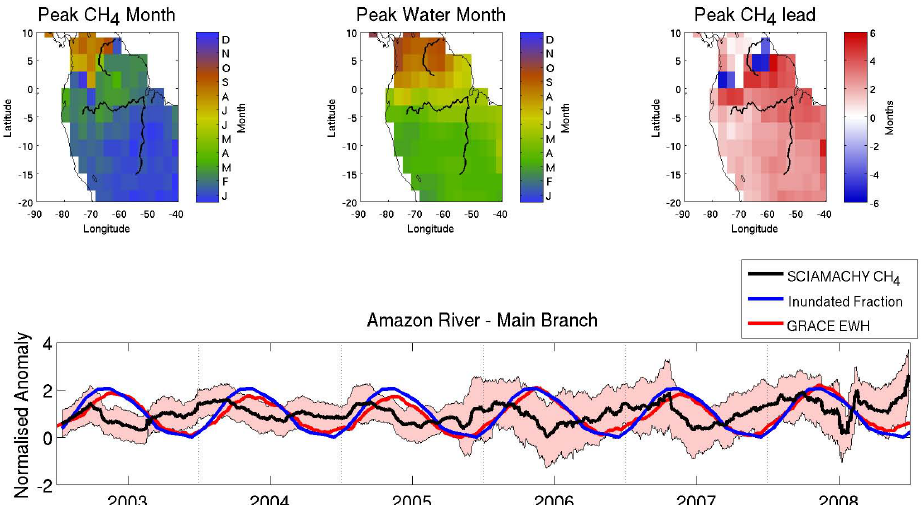
Fig. 1. Top: The timing (month of year) of peak CH 4 concentrations from SCIAMACHY (left), peak equivalent water height (EWH) from GRACE (middle), and the peak CH 4 concentration lead over tropical South America (right). Bottom: Normalised anomaly of GRACE EWH, mean flood fraction (Prigent et al., 2007), and mean CH 4 concentrations (including 1-standard deviation envelope) over the main branch of the Amazon River (0 ◦ –6 ◦ S, 40 ◦ –80 ◦